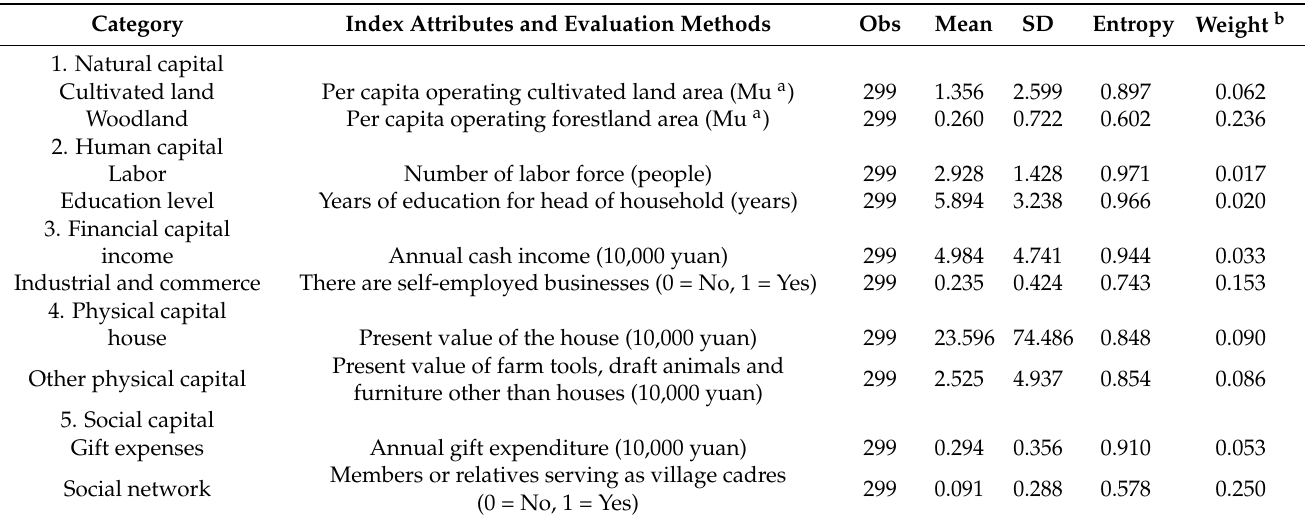
Table 1. Household livelihood capital index